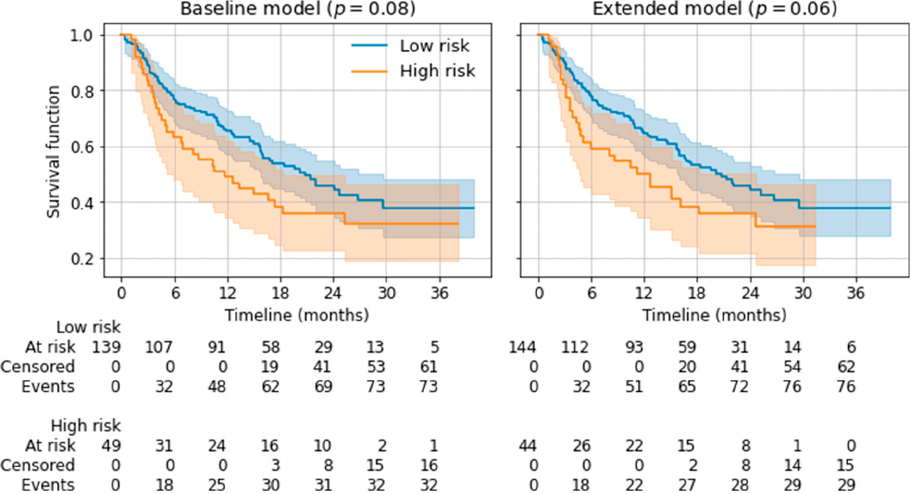
Figure 5. Kaplan–Meier estimators for low-risk and high-risk groups based on the predicted 12-month survival. P-values from log-rank tests are given for the distinction of both risk groups.